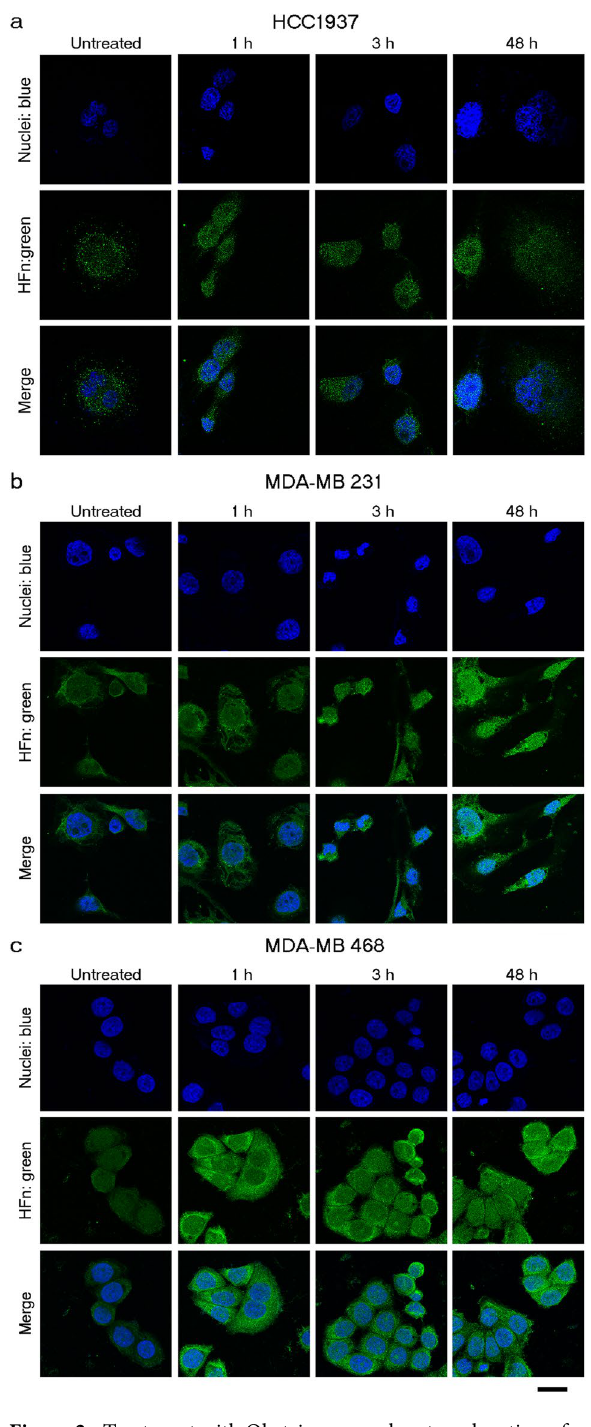
Figure 2. Treatment with Ola triggers nuclear translocation of endogenous HFn. Confocal microscopy images of MDA-MB 231, MDA-MB 468 and HCC1937 cells incubated for 1, 3 and 48 h at 37 °C with 1 µ M Ola. Cells not previously treated with Ola were used as negative control (untreated). Nuclei were stained with DAPI (blue). Endogenous ferritin was recognized with anti-ferritin antibody and labeled with an anti-rabbit secondary antibody conjugated with Alexa Fluor 488 (green; Thermo Fischer Scientific). Scale bar: 10 µ